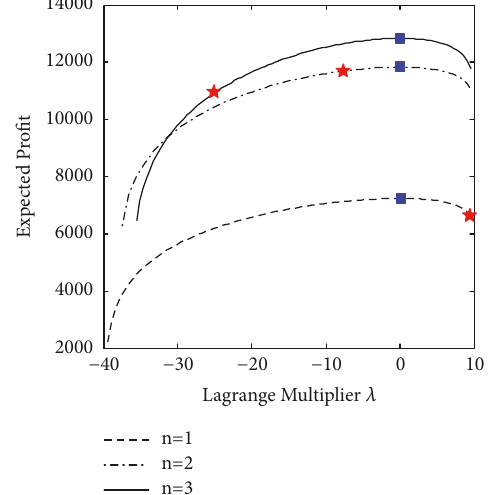
total order quantity curve, and the approximate optimal total order quantity is much larger than that without the order ̃𝜆 ∗ quantity constraint; when n =2, is on the left side of the zero, and the approximate optimal total order quantity